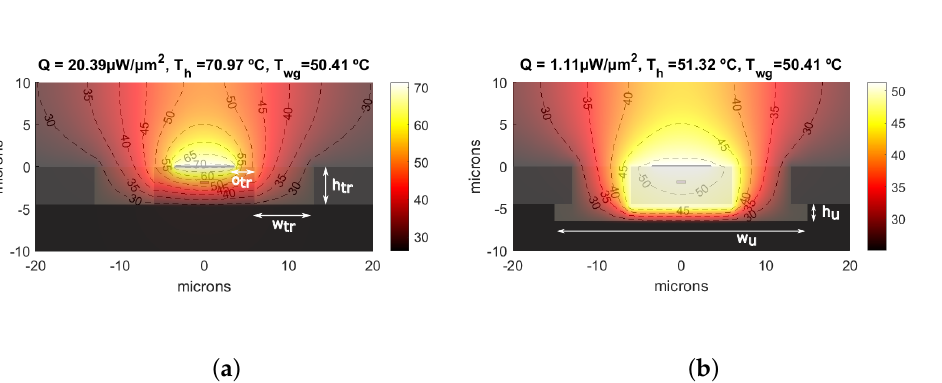
Figure 2. Cross-section temperature distribution for the air-filled trench ( a ) and the air-trench with Si undercut ( b ). Both with o tr of 2.5 µ m, heater and trench widths 7 µ m, with heating element length l h = 1